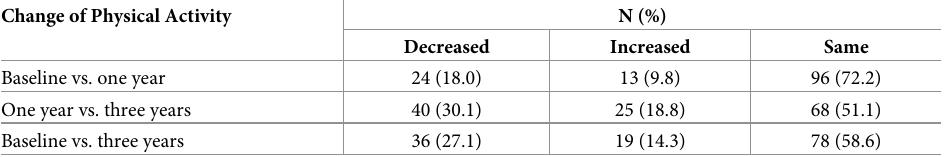
Table 4. Changes of physical activity